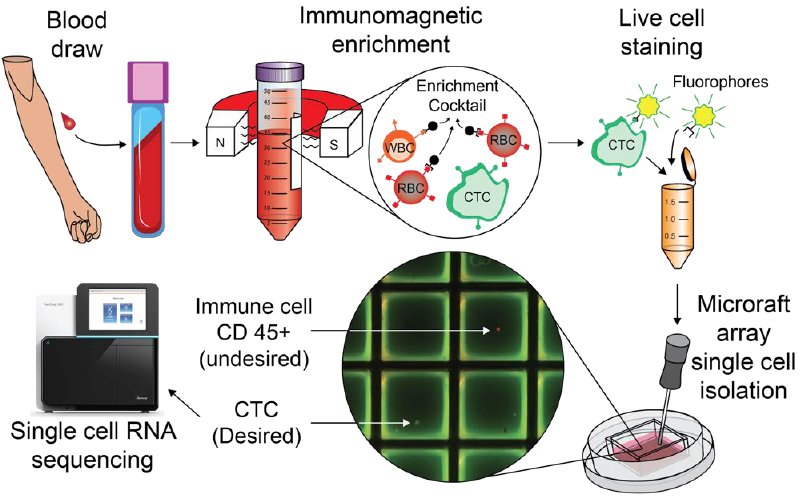
Figure 1. CTC Isolation Workflow. Up to 20 mL of melanoma patient blood is drawn. Using the StemCell Technologies EasySep Direct Human CTC Enrichment Kit, all undesired components of the blood are removed including red and white blood cells. Enriched CTCs are stained, live, via direct immunofluorescence, and then plated on a CytoSort Array. Cells that positively stain for the melanocyte cocktail and Hoechst, and negatively for CD45, are picked with a magnetic wand and deposited in a PCR tube with lysis buffer. Libraries are prepared for single-cell RNA sequencing according to the Smart-seq2 protocol and sequenced on a next-generation sequencing platform.